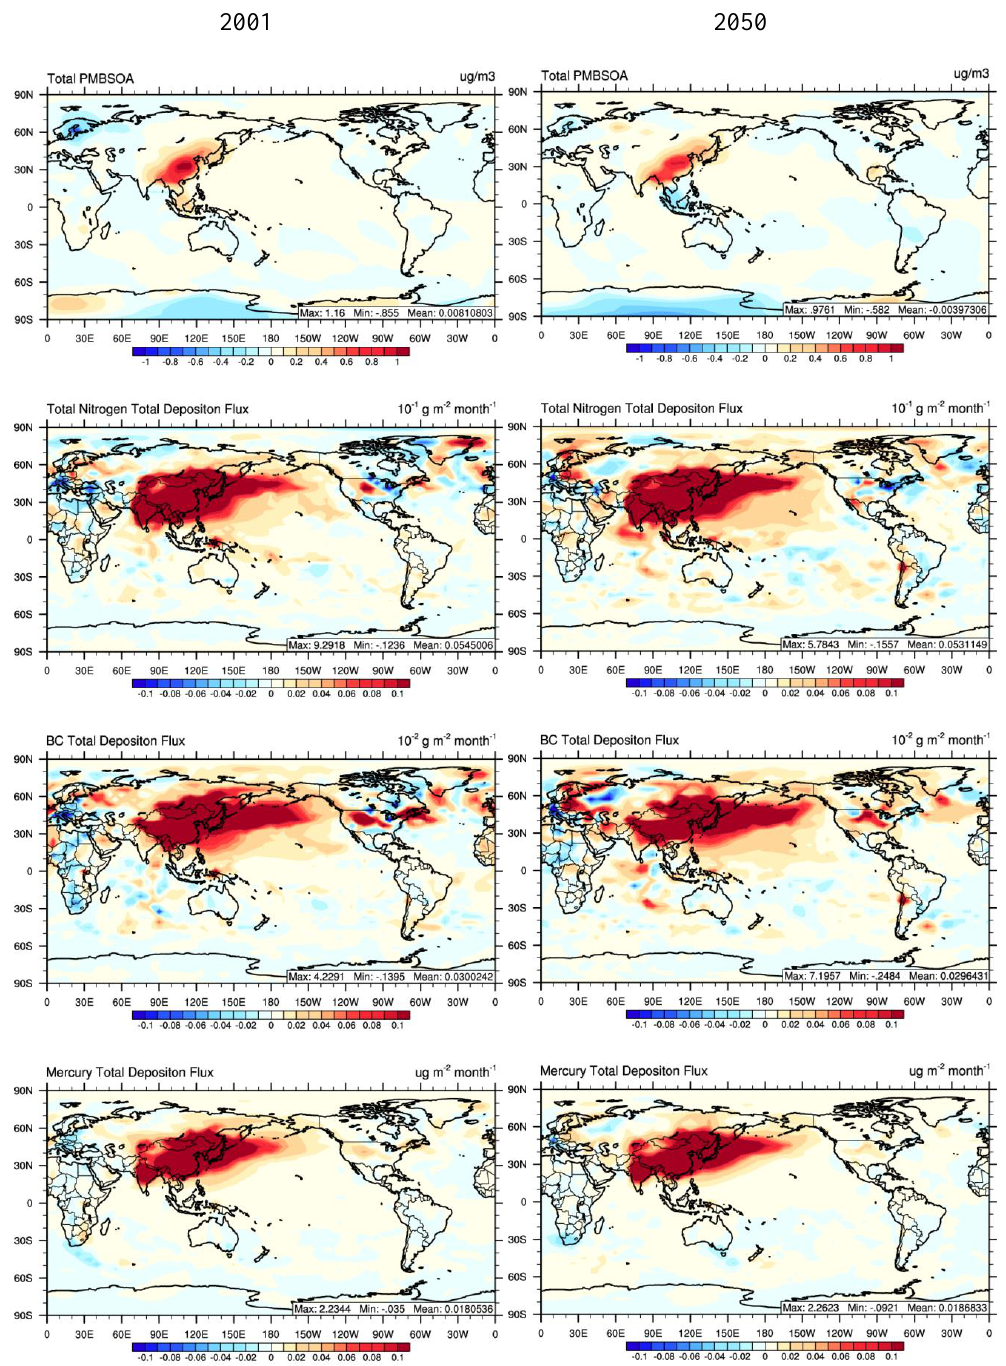
Figure 8. The difference in the spring (MAM) BSOA concentration (row 1), total deposition of total nitrogen (row 2), black carbon aerosol (row 3), and total gaseous and particulate mercury (row 4) between the simulations with and without EAAEs for the current (2001) and future (2050) scenarios.